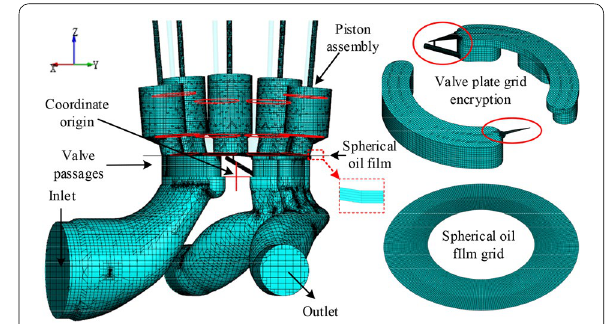
Figure 2 Three-dimensional whole pump binary tree Cartesian grid for axial piston